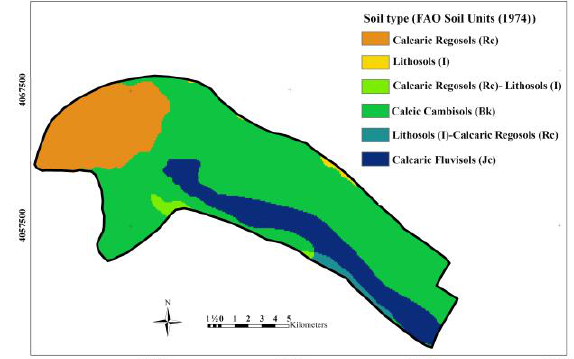
Figure 5. The soil type map of the study area according FAO soil units (1974)